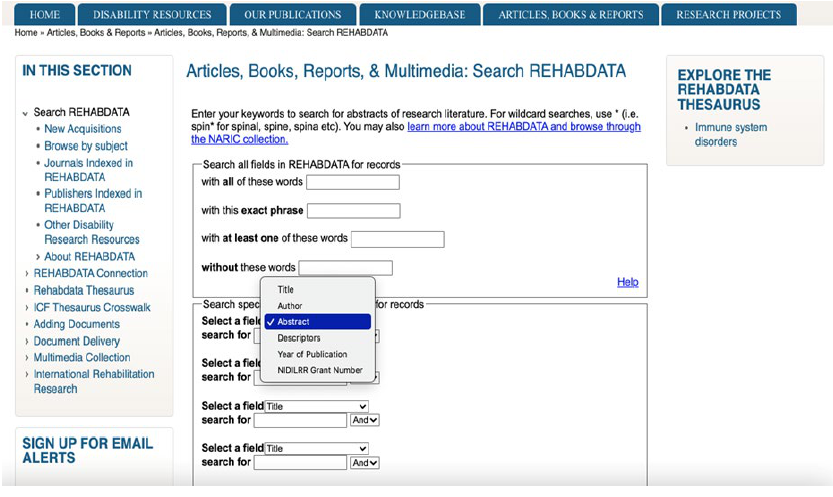
Figure 2 Filter options in the advanced search in REHABDATA, “Articles, Books, Re- ports, & Multimedia”